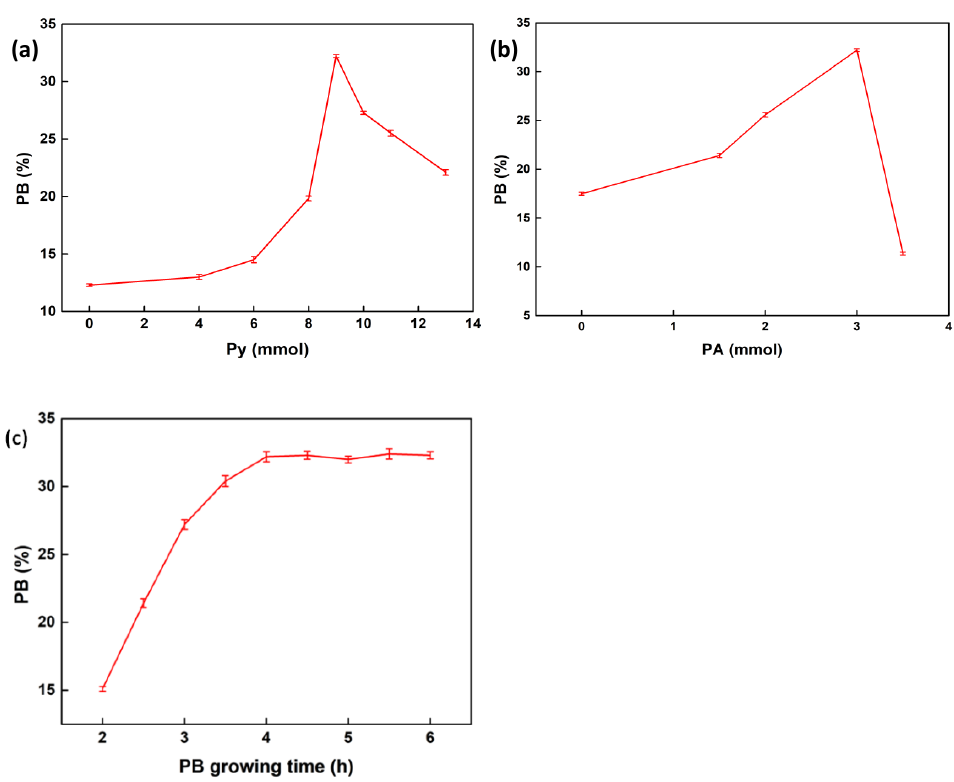
Figure 2. Effect of Py dosage ( a ), PA dosage ( b ), and PB growing time ( c ) on PB deposition.